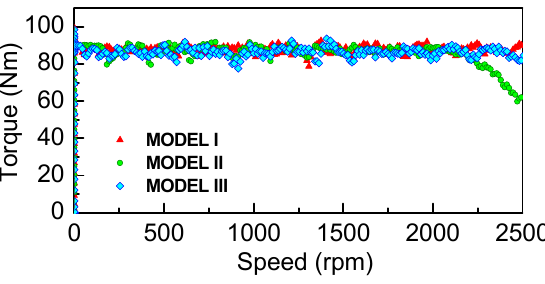
Figure 19. Torque-speed characteristic in different models under T e * = 90 Nm.